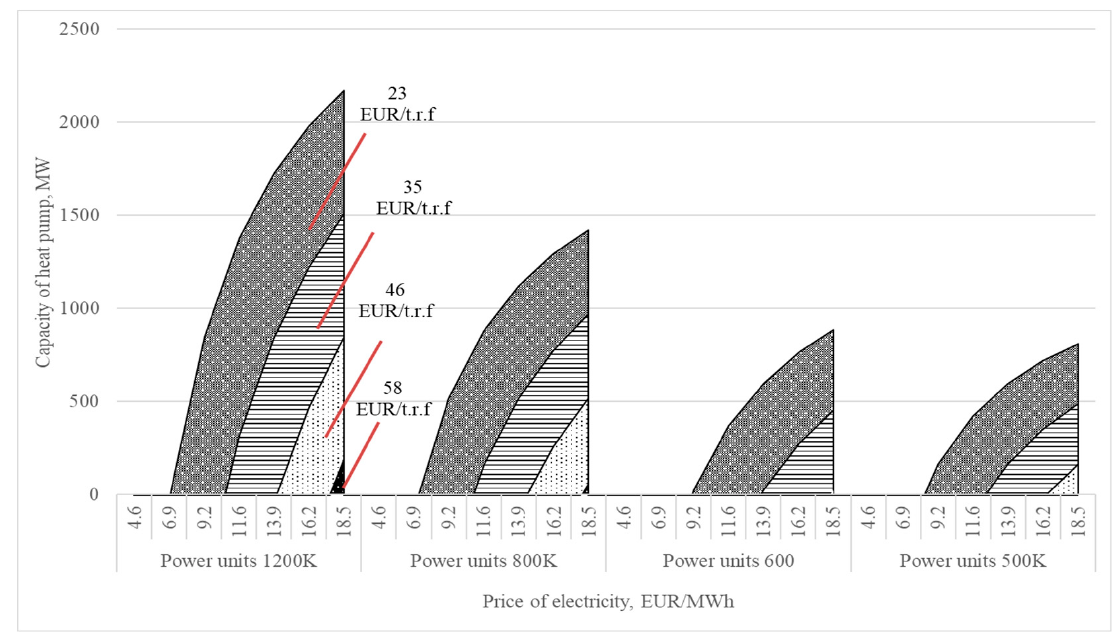
Figure 8. The range of permissible HP capacities for high-capacity TPPs.